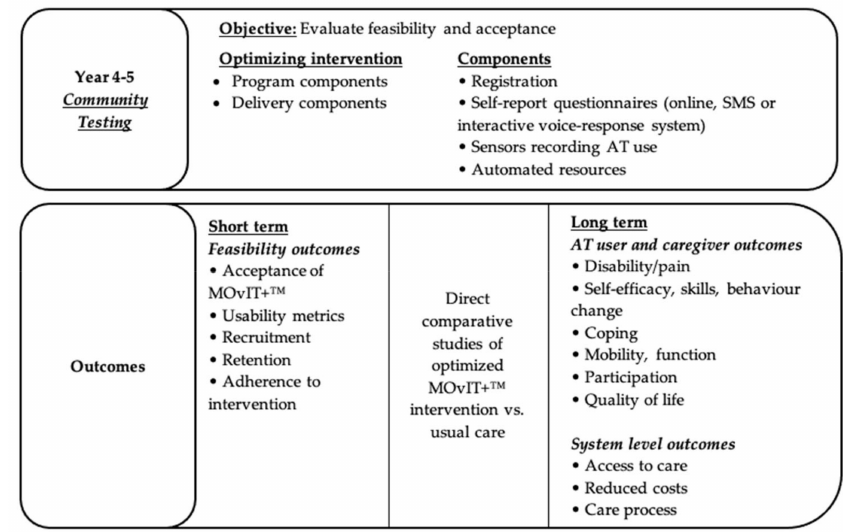
Figure 2. Logic model of the